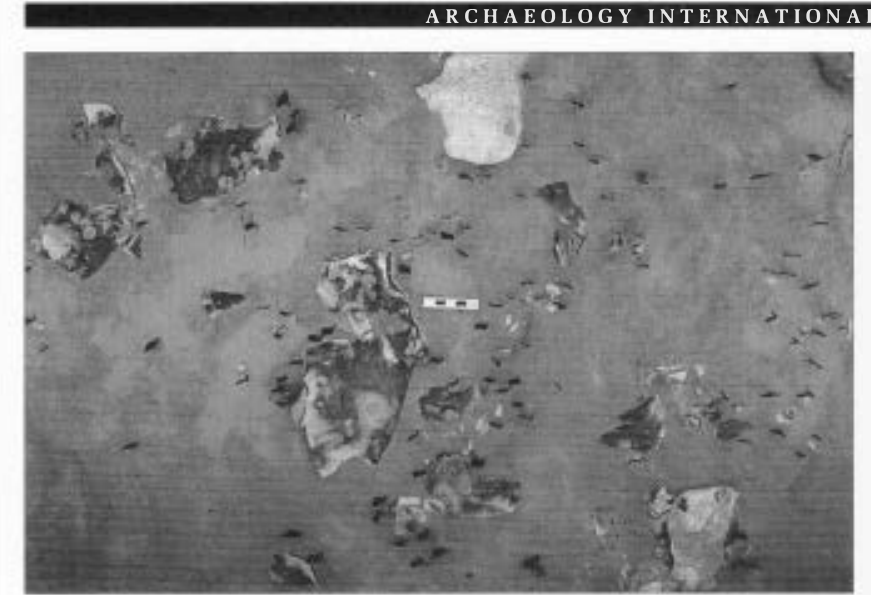
A scatter of refitting flint waste at GTP 1 7, where a horse was butchered; scale in lOmm divisions.